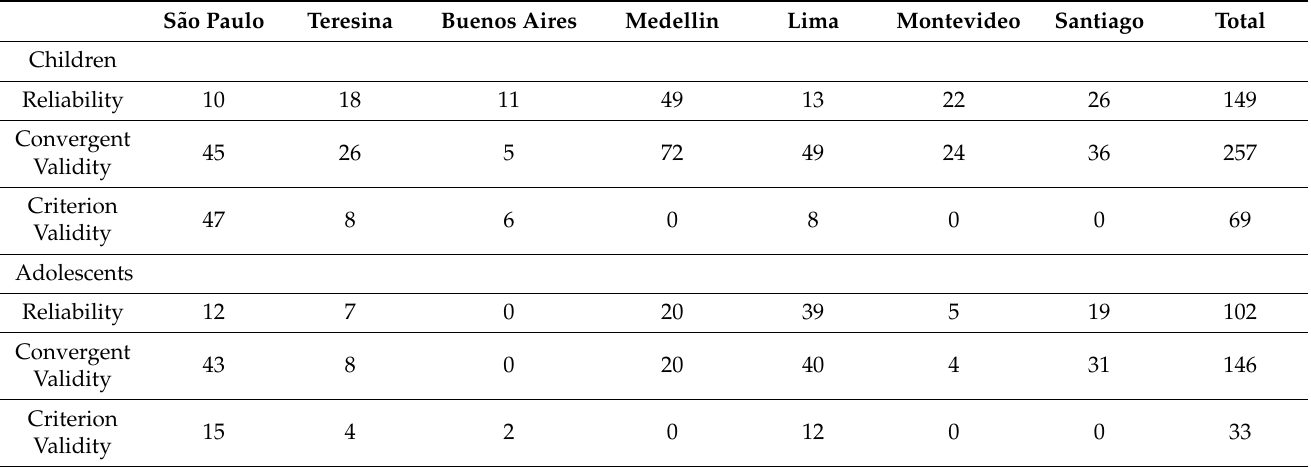
Table 1. Composition of samples with the number of participants by center (SAYCARE) for reliability and validity of PAIFIS using an FFQ for inflammatory foods.